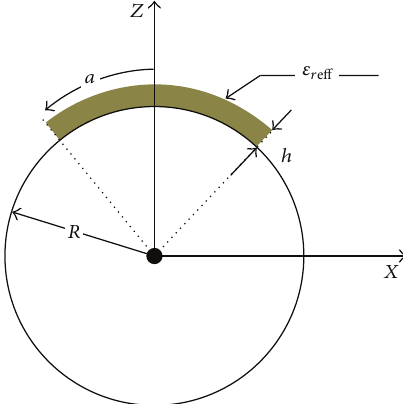
Figure 1: Cylindrical-circular patch microstrip printed antenna geometry